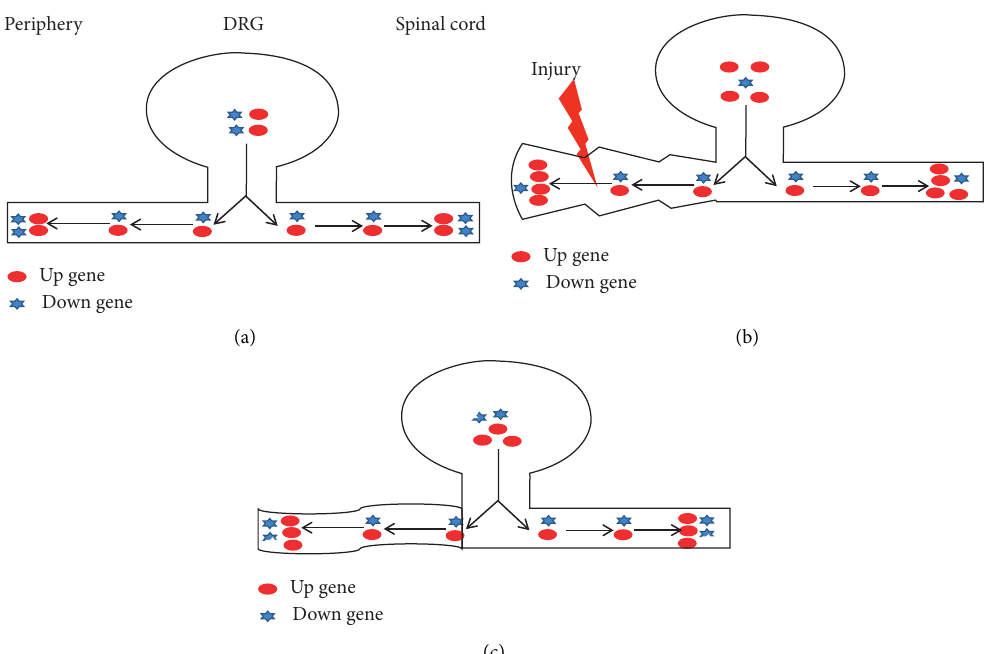
Figure 5: Diagram of repair mechanism of DRG in rats with nerve injury intervened by three methods and three acupoints. (a) Sham group. (b) SNI group. (c) Tuina